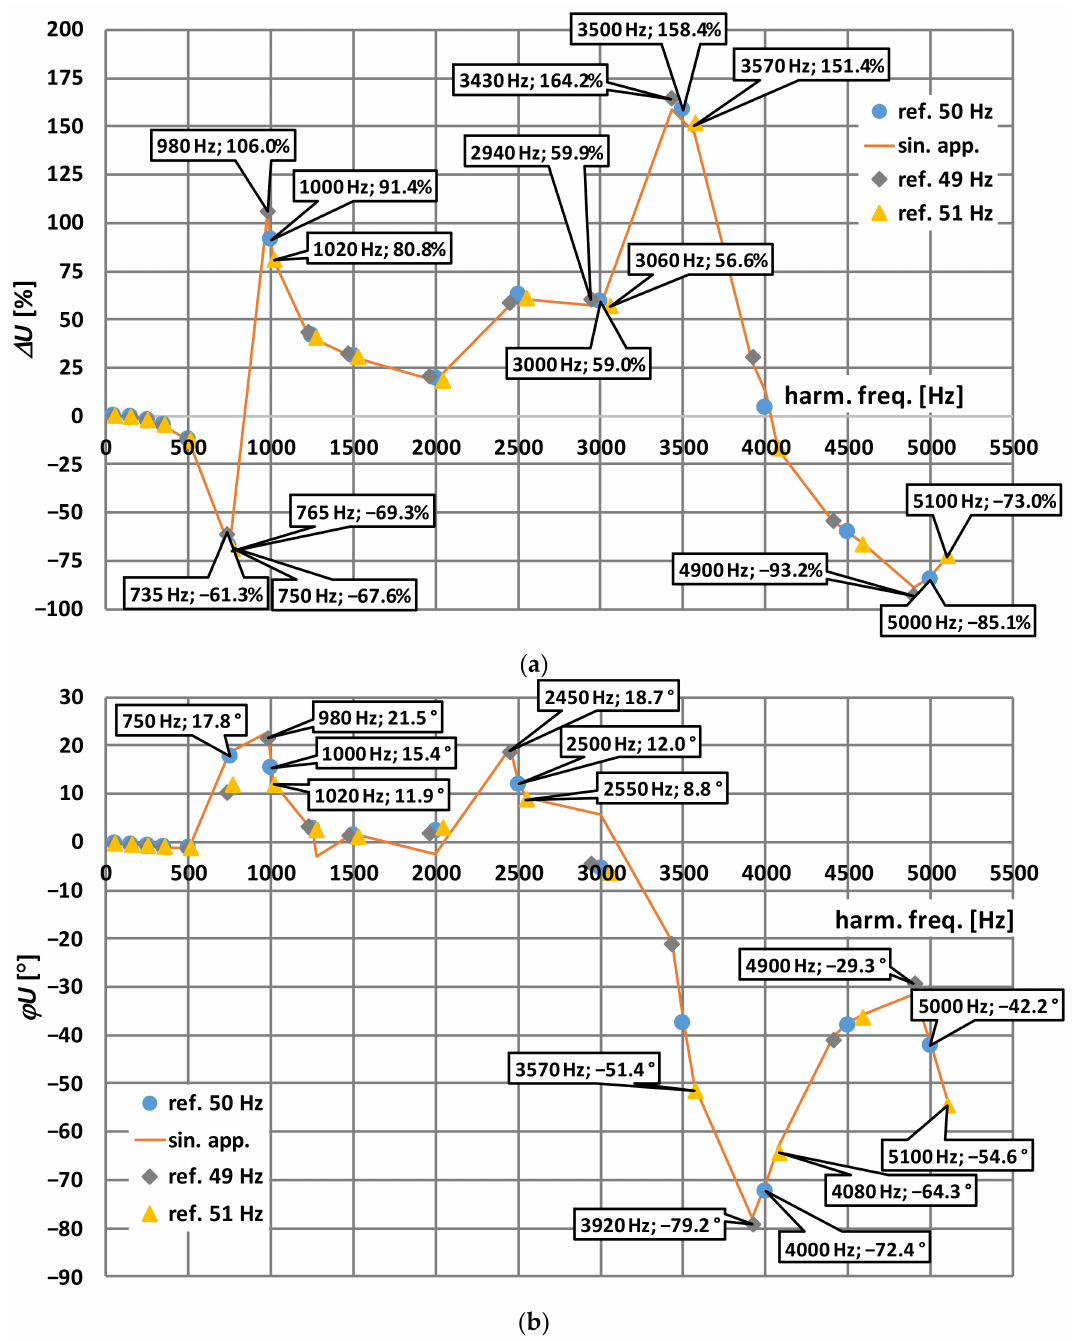
Figure 2. Comparison of the transformation accuracy of the 20 kV VT for harmonics of the non-sinusoidal and sinusoidal primary voltage: ( a ) voltage error, ( b ) phase